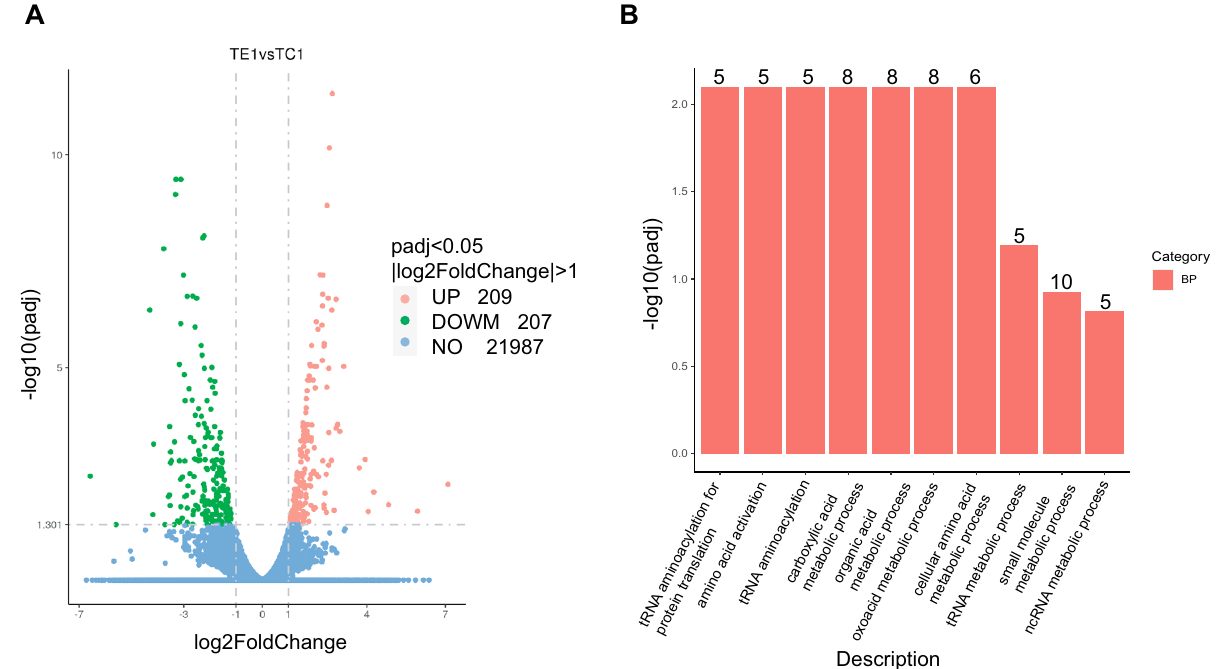
Figure 2. Transcriptome analysis of cells cultured in a basket bioreactor. ( A ) Differentially expressed genes in cells cultured in the basket bioreactor. ( B ) GO analysis of differentially expressed genes in cells cultured in the basket bioreactor. TE1 samples from the basket bioreactor, TC1 control